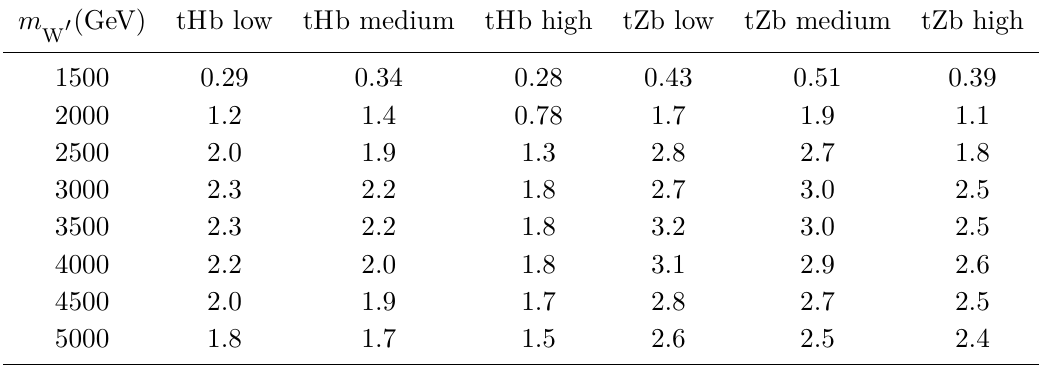
Table 2 . The signal efficiency (in percent) for the three VLQ mass ranges considered. The efficiency is given for the tHb and tZb final states, separated into the low, medium, and high VLQ mass